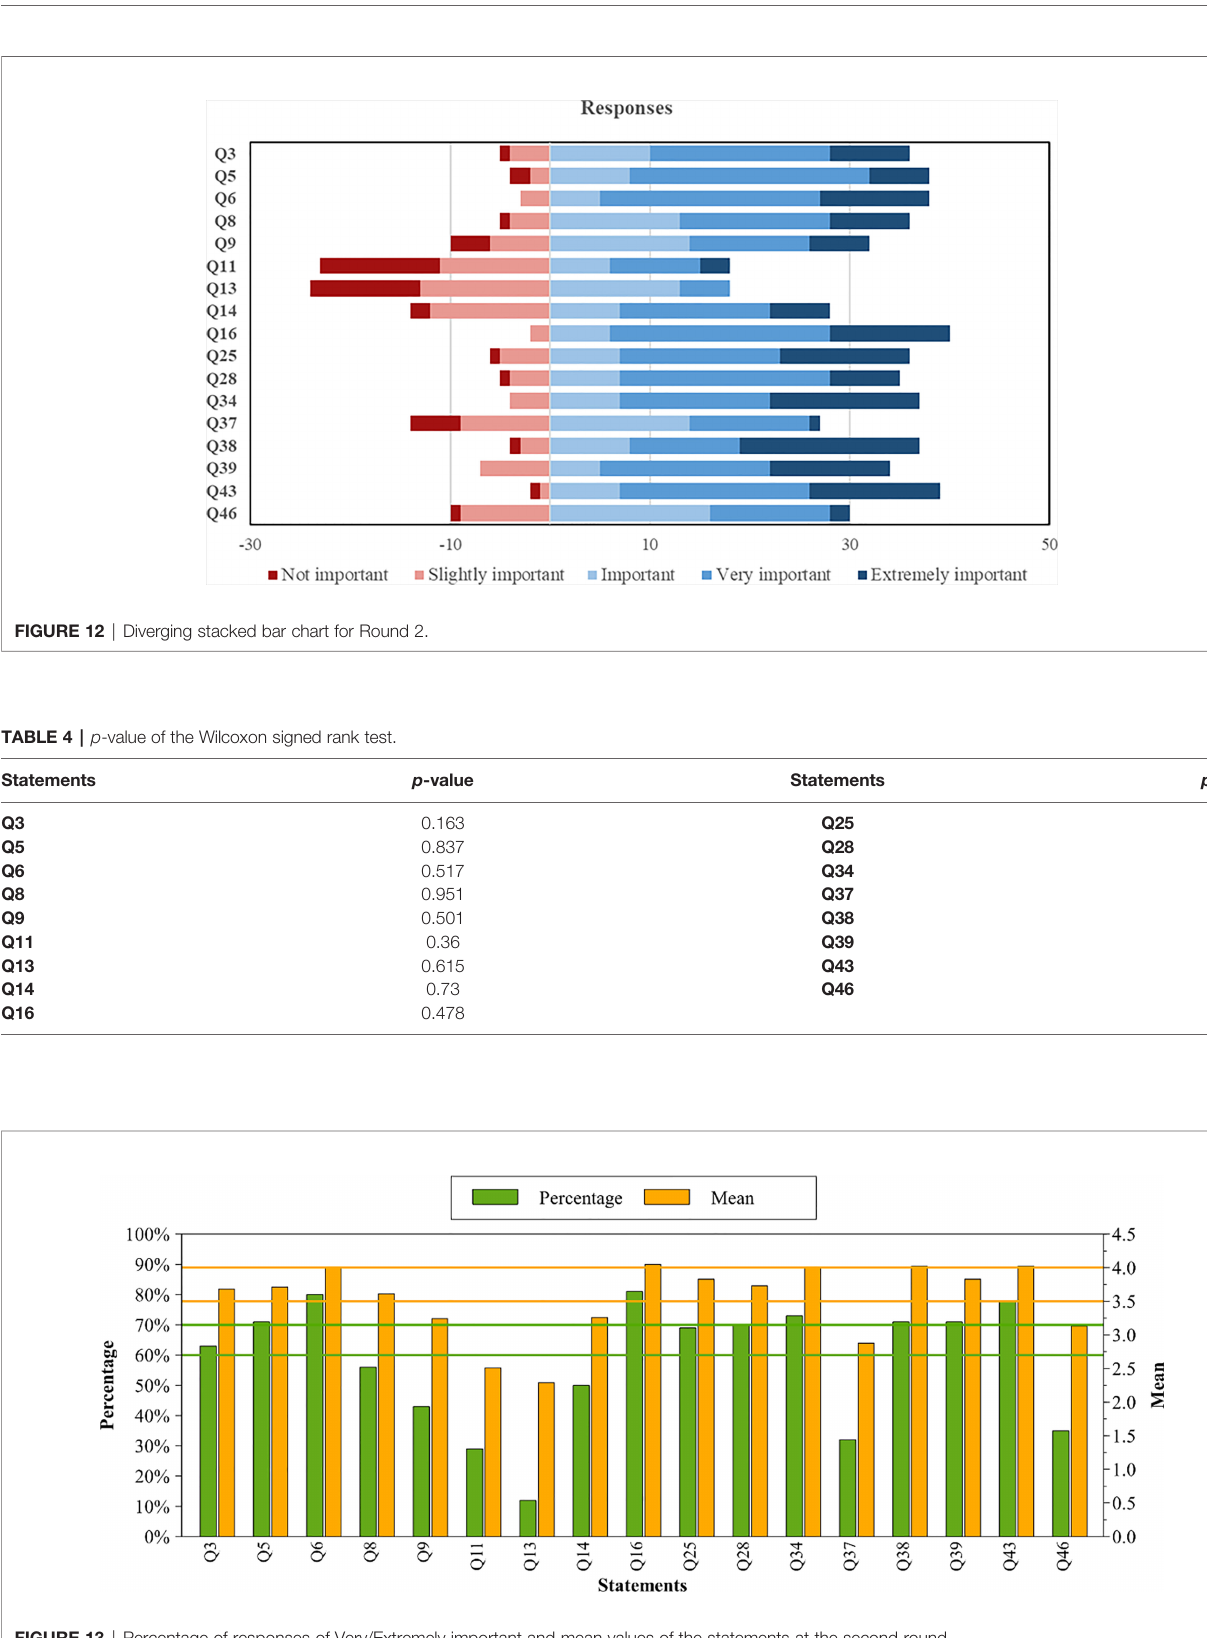
FIGURE 13 | Percentage of responses of Very/Extremely important and mean values of the statements at the second